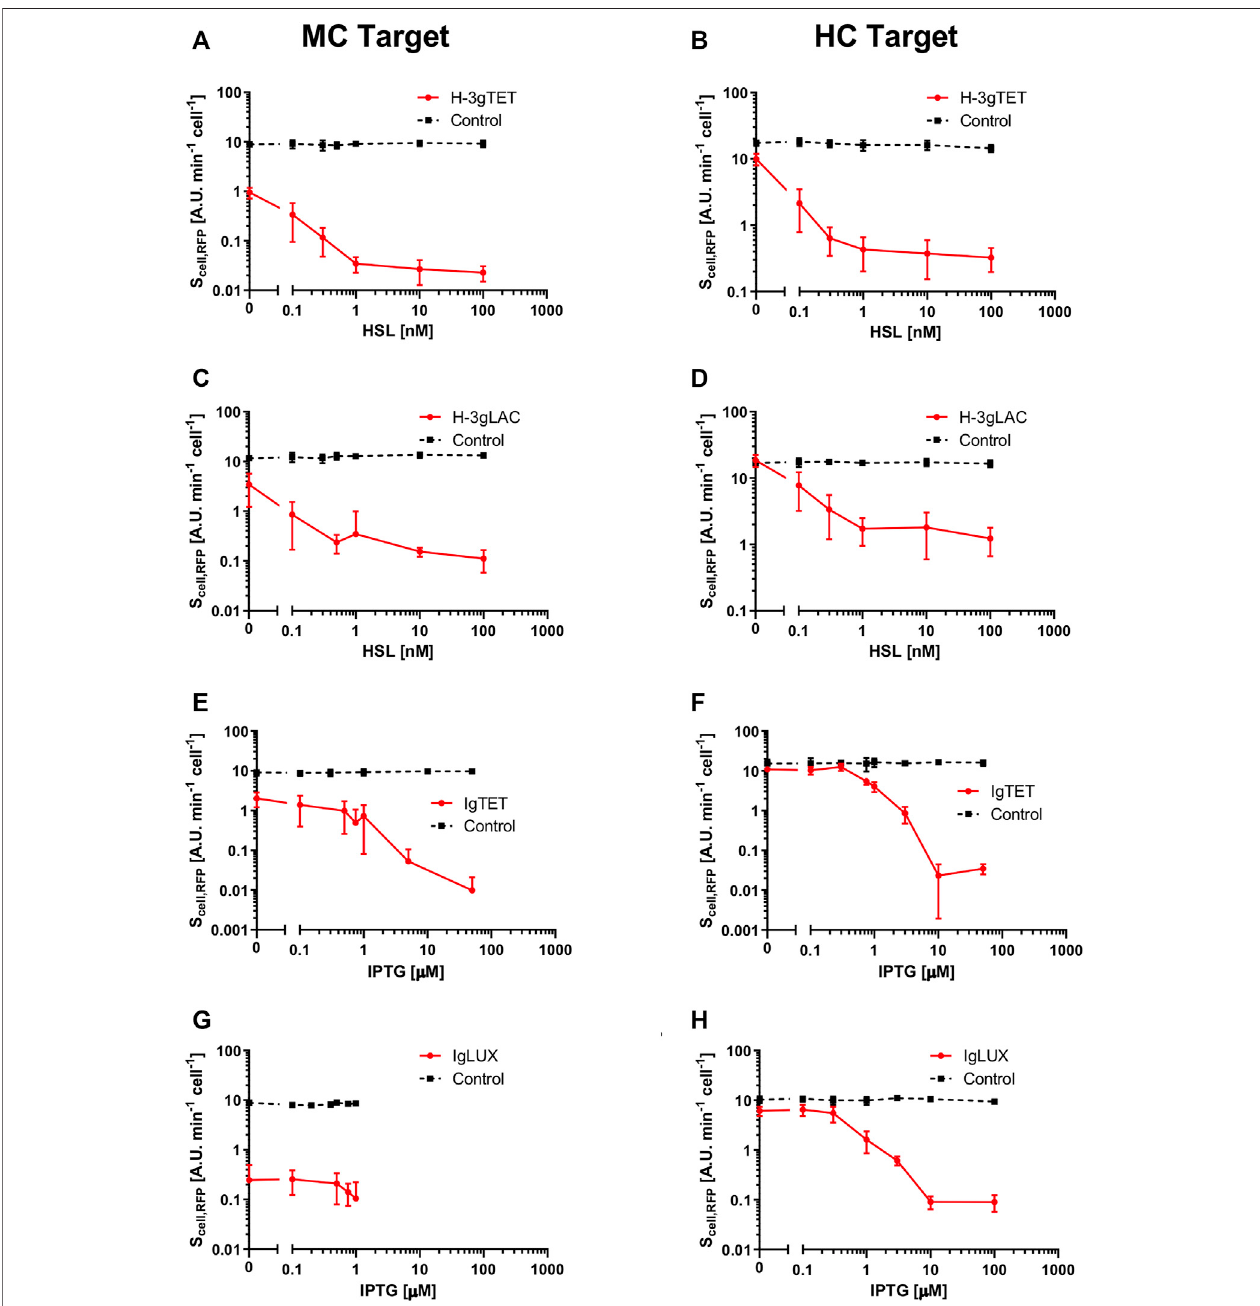
FIGURE5| TransferfunctionsofrecombinantstrainswithconstitutivedCas9andinduciblesgRNA.Transfercurves,withRFPasoutput,arereportedasafunction of the inducer concentration driving sgRNA expression [HSL, in panels (A – D) , or IPTG, in panels (E – H) ]. Data are shown as the average RFP synthesis rate per cell. In eachpanel,theCRISPRitargetingsystemwithgPtet,gPlacandgPluxH,whichrepresstheP LtetO1 ,P LlacO1 andP luxRep targetpromoters,respectively,isshown,usingthe strain nomenclature of Supplementary Table S1 . In particular, H -3 gTET, H -3 gLAC, IgTET and IgLUX indicate HSL-inducible gPtet, HSL-inducible gPlac, IPTG- inducible gPtet and IPTG-inducible gPluxH cassettes in low-copy plasmid. Two different copy number contexts for the target are reported: medium copy (MC) and high copy (HC). Each panel includes two curves, corresponding to circuits with speci fi c or non-speci fi c targeting system. The latter is referred to as control and the used sgRNAsaregPlac[panels (A,B) ],gPtet[panels (C,D) and (G,H) andgPluxH (E,F)] .Datapointsrepresenttheaveragevalueanderrorbarsrepresent thestandarderrors of the mean of at least three independent experiments.